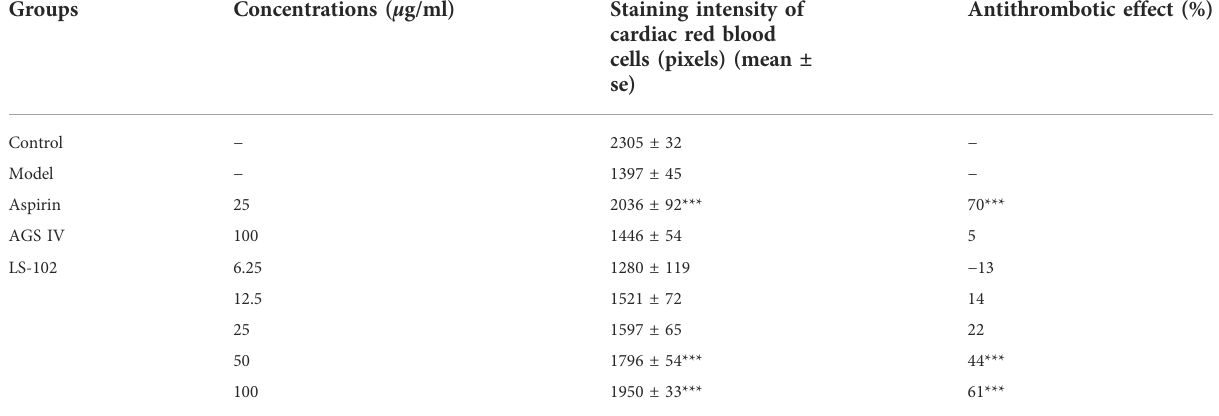
TABLE 6 Quantitative results of the effect of LS-102 and AGS IV on the prevention of thrombosis in zebra fi sh ( n = 10). Groups